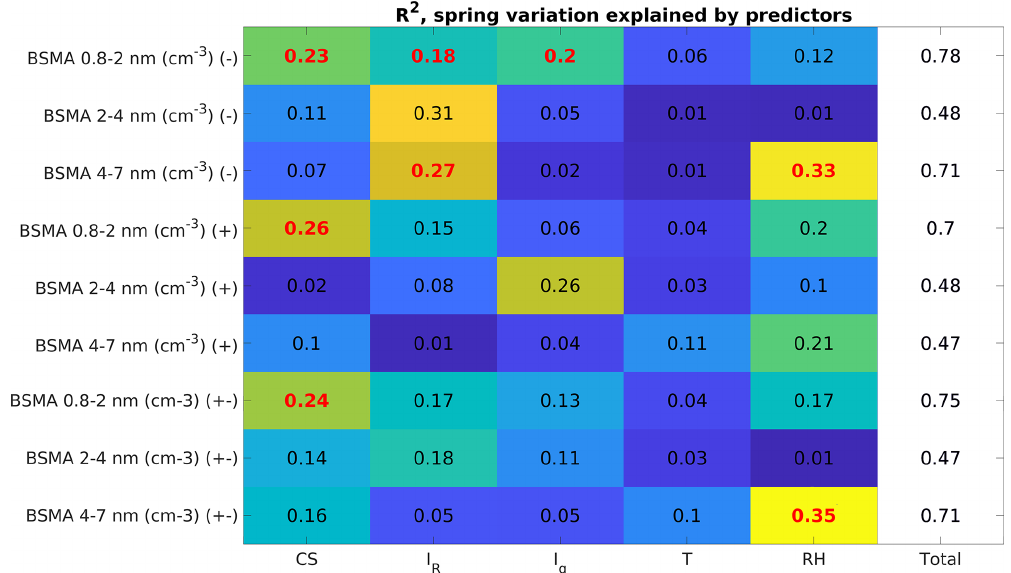
Figure A3. The amount of variation explained by our chosen explanatory variables for each size range and polarity. The data points selected are only between March and May and represent changes in springtime concentrations. The symbol ( − ) denotes negative polarity, ( + ) a positive polarity, and ( ± ) the sum of both polarities. The bolded red values are statistically significant ( p < 0 . 05).